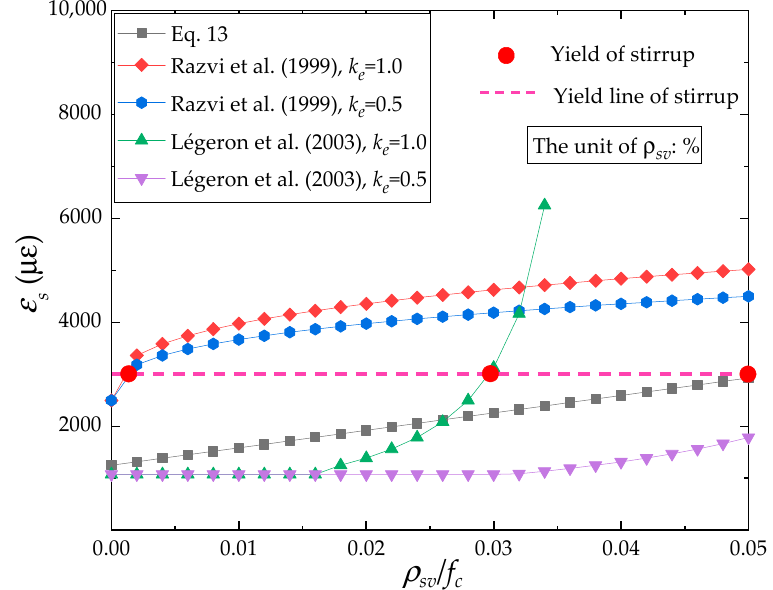
Figure 10. Comparison of empirical formulae for di ff erent ties stresses [20,21].